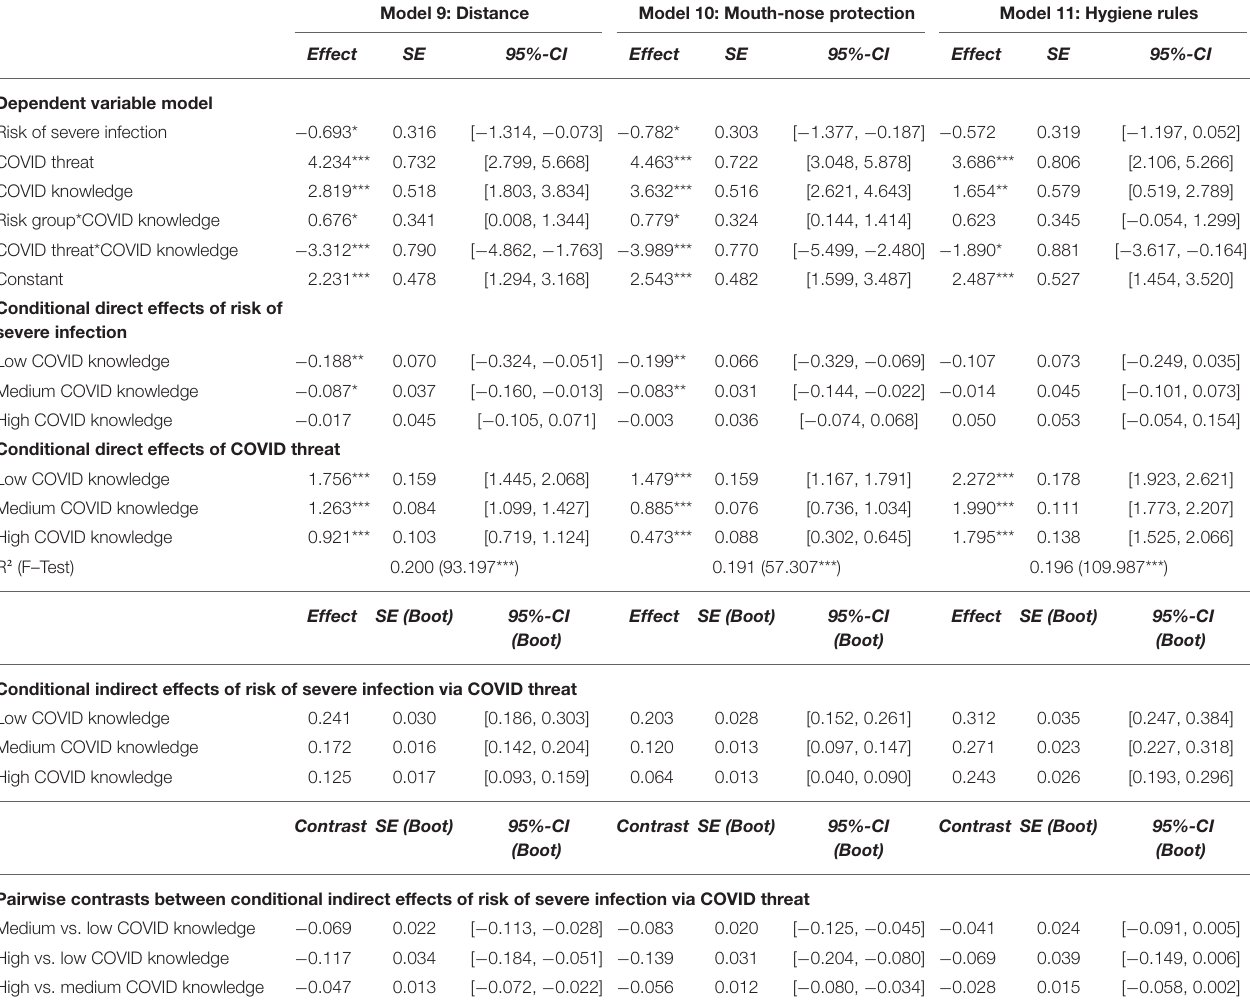
TABLE 6 | Dependent variable model of the conditional mediation model ( N = 4,096) a